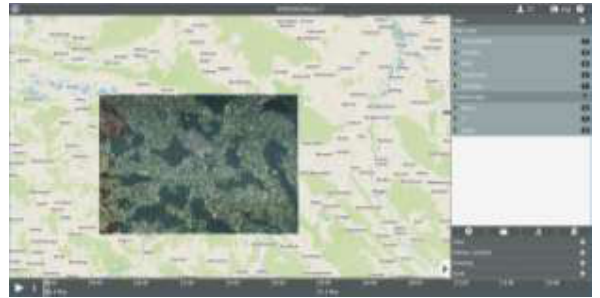
Figure 8: GUI of the DigLT software